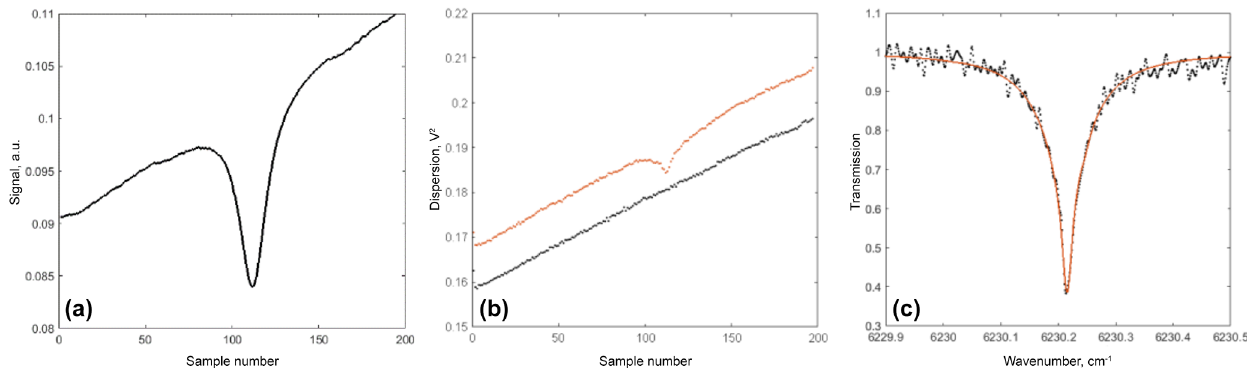
Figure 2. Heterodyne signal treatment in the LHS: (a) signal in the reference channel during one cycle of laser pumping current ramping; (b) noise dispersion in the heterodyne channel during one cycle of laser pumping current ramping; blue dots – with the Sun off, red dots – with the Sun on; (c) atmospheric transmission spectrum obtained after removing dark signal, normalization to suggested continuum (baseline), and frequency calibration. Black dots – experiment, red curve – model fit.